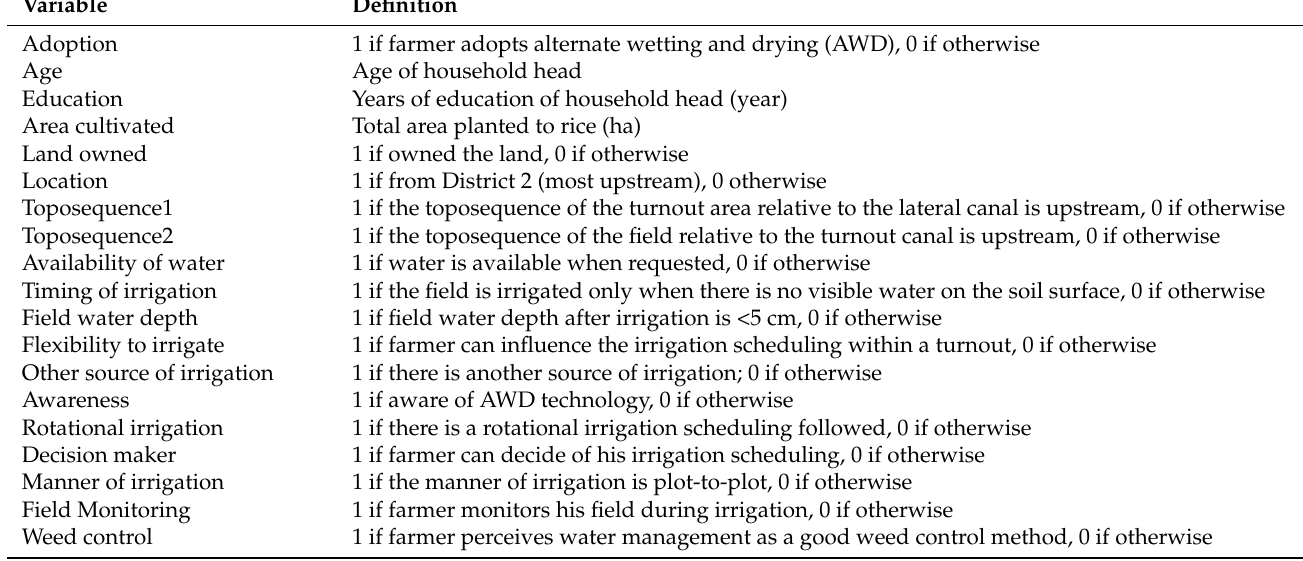
Table 2. Definition of